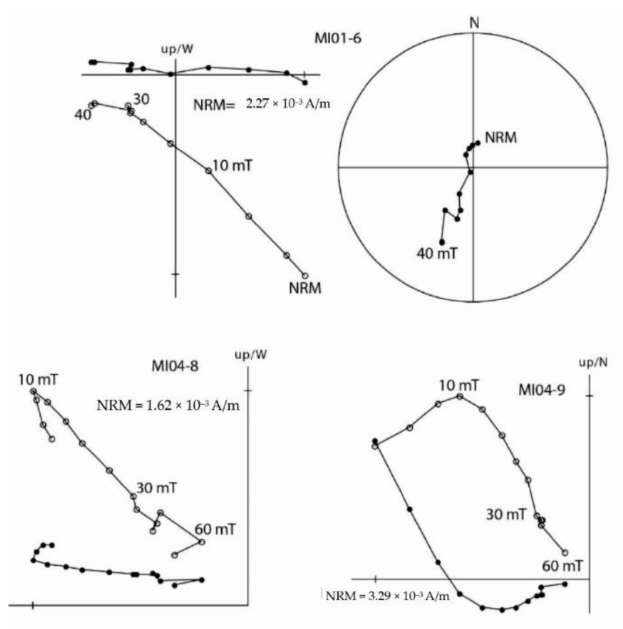
Figure 7. Progressive demagnetization diagrams of representative samples. Each data point rep- resents the NRM end vector for individual demagnetization steps projected onto the horizontal (solid symbols) and vertical (open symbols) plane on the Zijderveld diagram. All samples were demagnetized with alternating field (steps shown in milliTesla). Natural remanent magnetization (NRM) shows initial magnetic intensity previous to AF procedure. Sample MIR01-6 shows a linear trend that bypass coordinate origin during AF demagnetization. On stereographic projection, a great circle is observed, which suggests the presence of a higher coercivity reverse magnetization component unresolved with AF. Specimens MI04-8 and MI04-6 show progressive decay after 10 mT, where a viscous component is